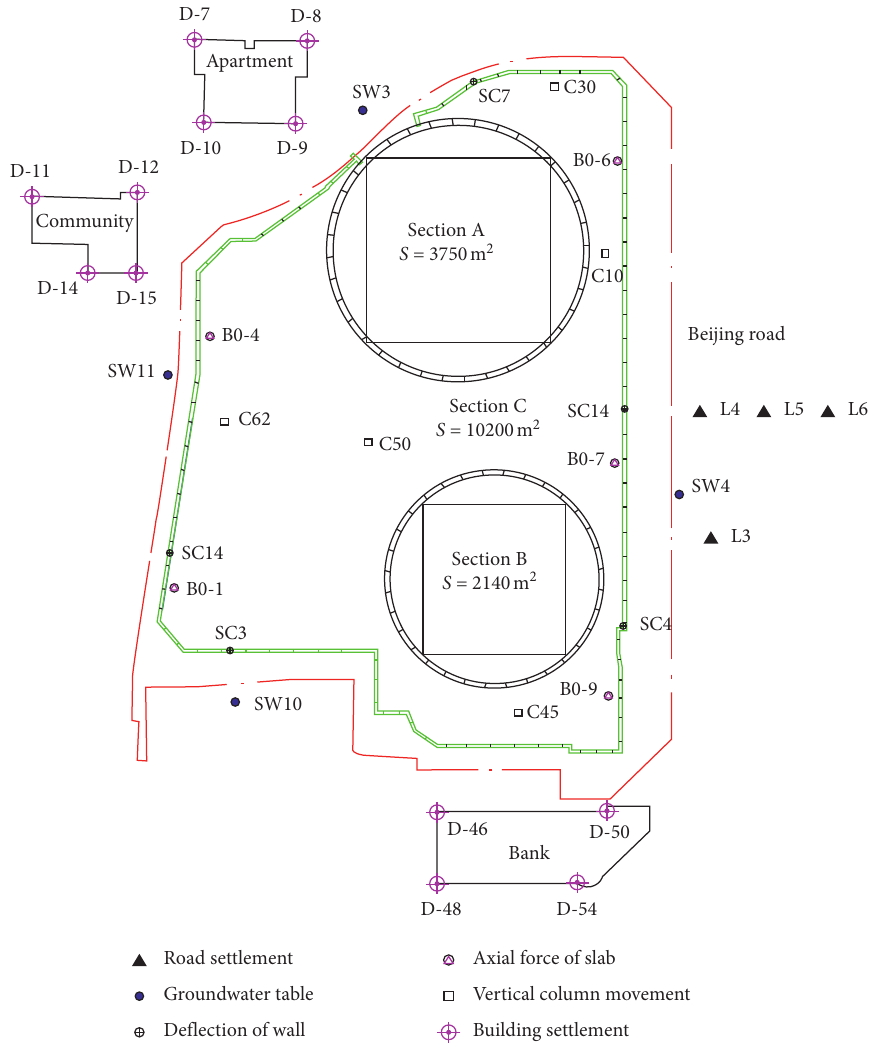
Figure 4: Instrumentation layout of the